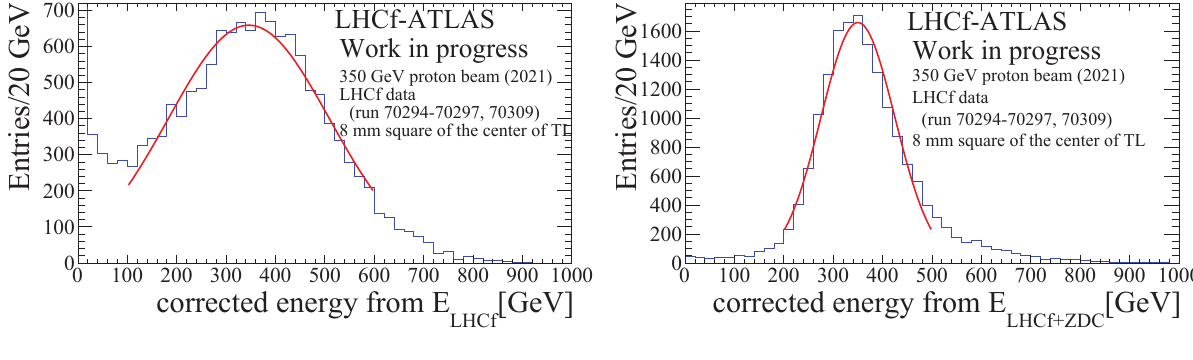
Figure 3. The distributions of ‘corrected energies’. The red curves show Gaussian fits to the data. (left) Corrected energy from total energy deposit of LHCf only. (right) Corrected energy estimated from the summation of total energies in LHCf and ZDC. a ∼ 0 . 0089 ± 0 . 0006 was used as the scale factor of